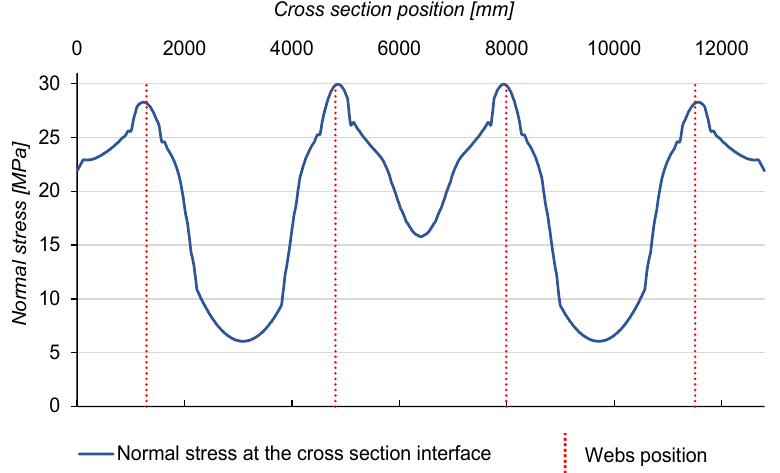
Figure 12. Occurrence of maximum normal stresses in the region of the webs in models with double box configuration.